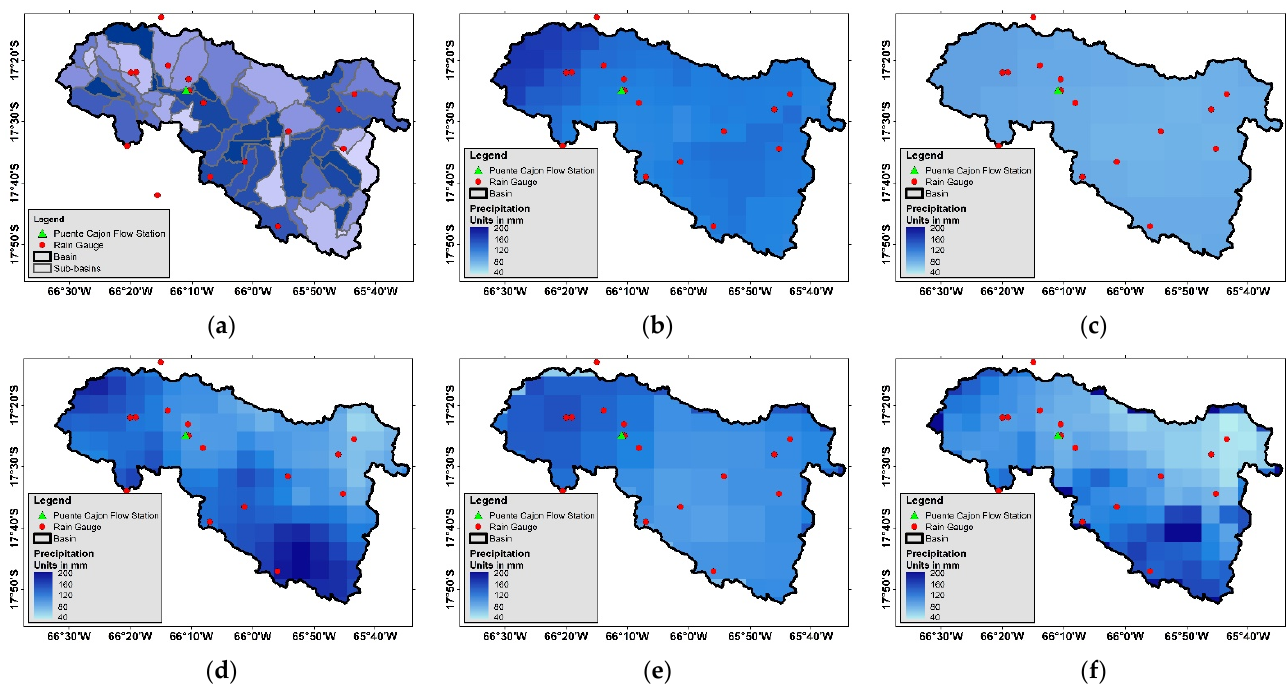
Figure 14. ( a ) Rocha sub-basin map, ( b ) rain gauge accumulated precipitation, ( c ) GSMaP accumu- lated precipitation, ( d ) CHIRPS accumulated precipitation, ( e ) GS accumulated precipitation and ( f ) CH accumulated precipitation from 17 to 31 January 2014.